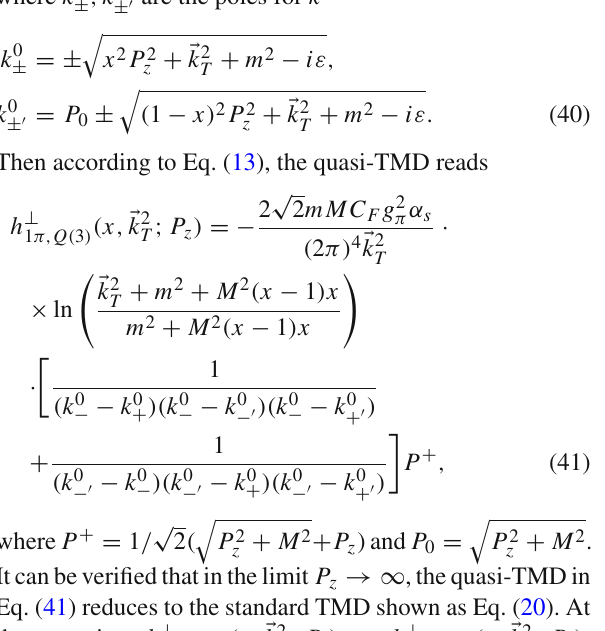
Fig. 1 The T-odd GTMD F o ( x ,ξ, (cid:2) k 2 , (cid:2) (cid:3) 2 ) at ξ = 0 . 1 and 0 . 5, respectively. The left and right panels F o F o T T 1